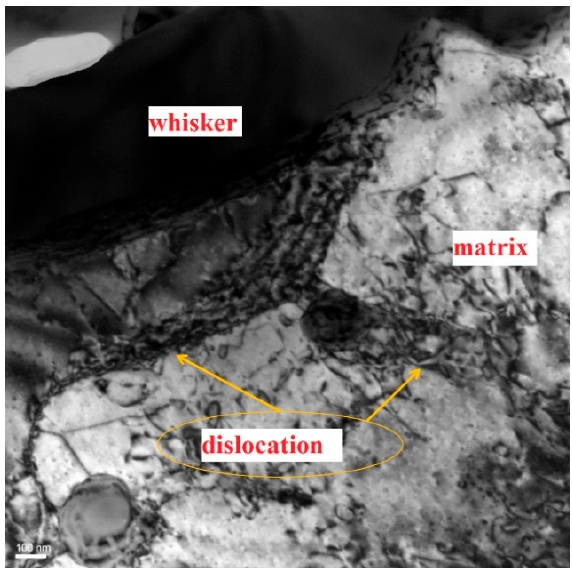
Figure 8. TEM image of microstructures after tensile creep deformation at 350 °C under 70 MPa.